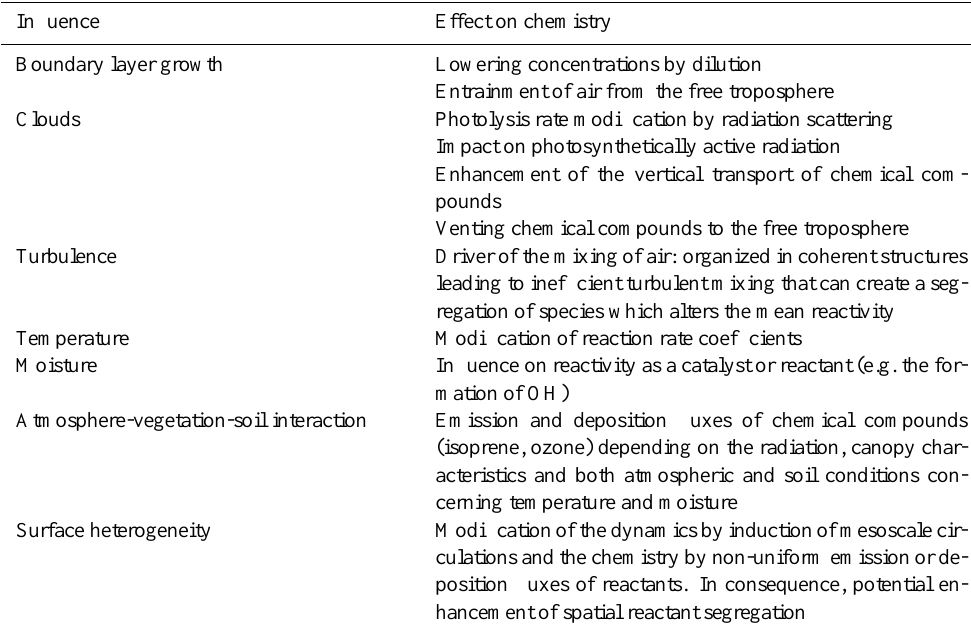
Table 1. Influence of ABL dynamics, radiation and surface conditions on atmospheric chemistry. Influence Effect on chemistry Boundary layer growth Lowering concentrations by dilution Entrainment of air from the free troposphere Clouds Photolysis rate modification by radiation scattering Impact on photosynthetically active radiation Enhancement of the vertical transport of chemical com- pounds Venting chemical compounds to the free troposphere Turbulence Driver of the mixing of air: organized in coherent structures leading to inefficient turbulent mixing that can create a seg- regation of species which alters the mean reactivity Temperature Modification of reaction rate coefficients Moisture Influence on reactivity as a catalyst or reactant (e.g. the for- mation of OH) Atmosphere-vegetation-soil interaction Emission and deposition fluxes of chemical compounds (isoprene, ozone) depending on the radiation, canopy char- acteristics and both atmospheric and soil conditions con- cerning temperature and moisture Surface heterogeneity Modification of the dynamics by induction of mesoscale cir- culations and the chemistry by non-uniform emission or de- position fluxes of reactants. In consequence, potential en- hancement of spatial reactant